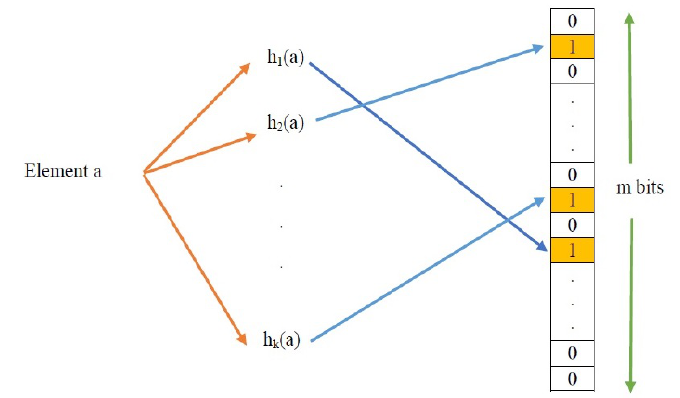
Figure 2. A basic Bloom filter with m bits and k hash